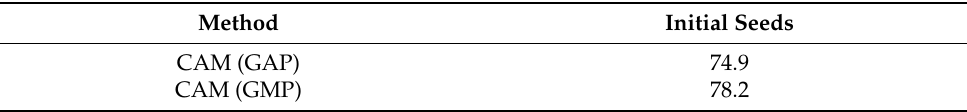
Figure 4. Different pooling methods of initial seeds on Majiagou data set training images. The green boxes represent regions of boundary blurring: ( a ) images; ( b ) ground truth; ( c ) initial seeds with GAP; and ( d ) initial seeds with GMP. Table 1. mIoU (%) of the initial seeds on Majiagou data set training